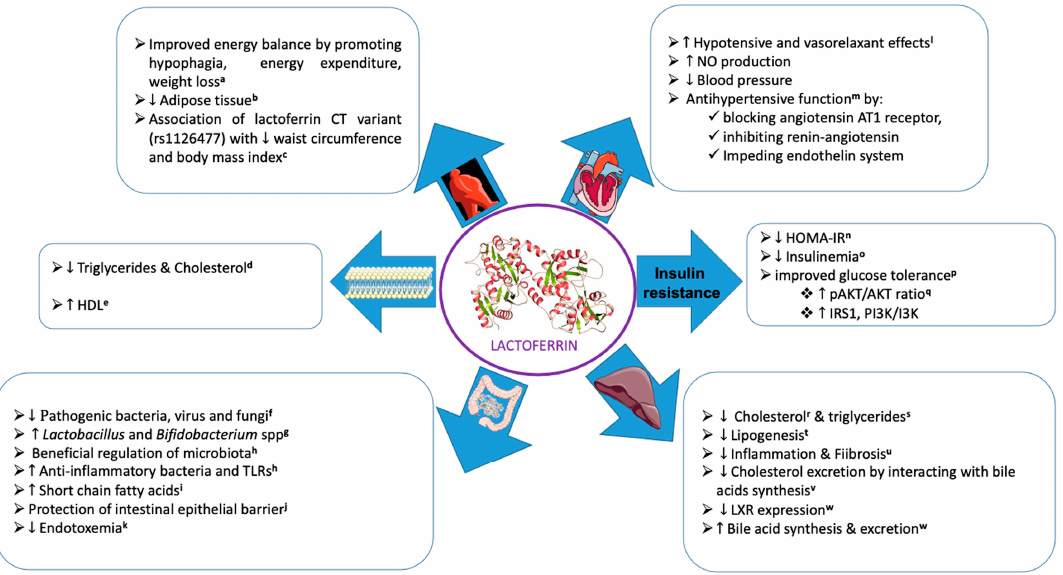
Figure 1. Pleiotropic functions of bioactive milk lactoferrin through several mechanisms. (The images used were extracted from Servier Medical Art). Related references cited in the Figure: ( a :